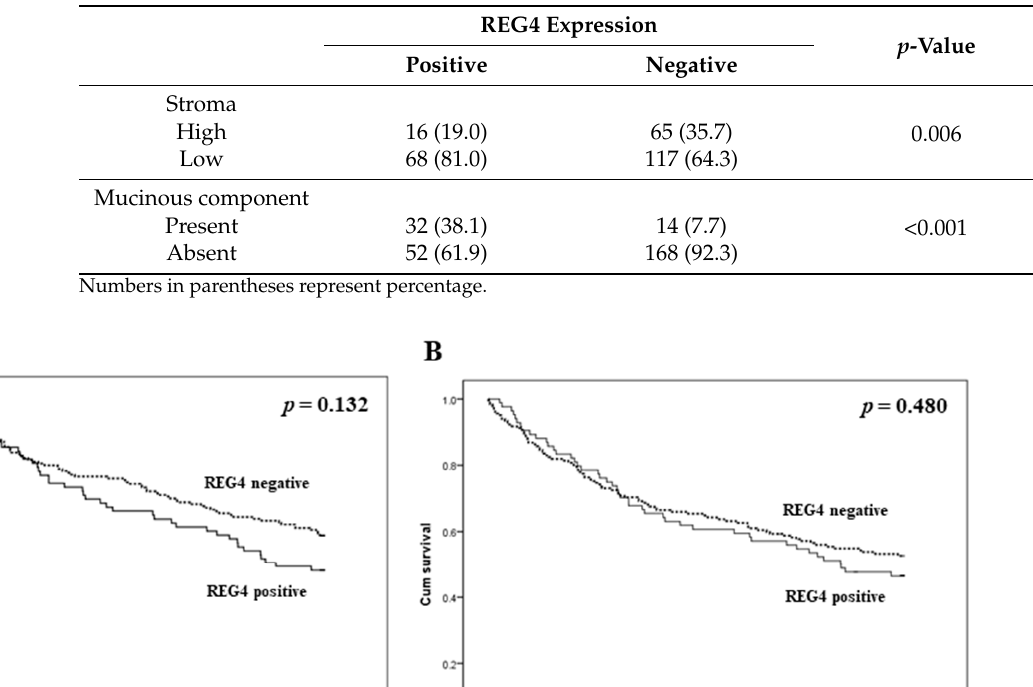
Table 2. The correlation between REG4 expression and tumor stroma in colorectal cancers.